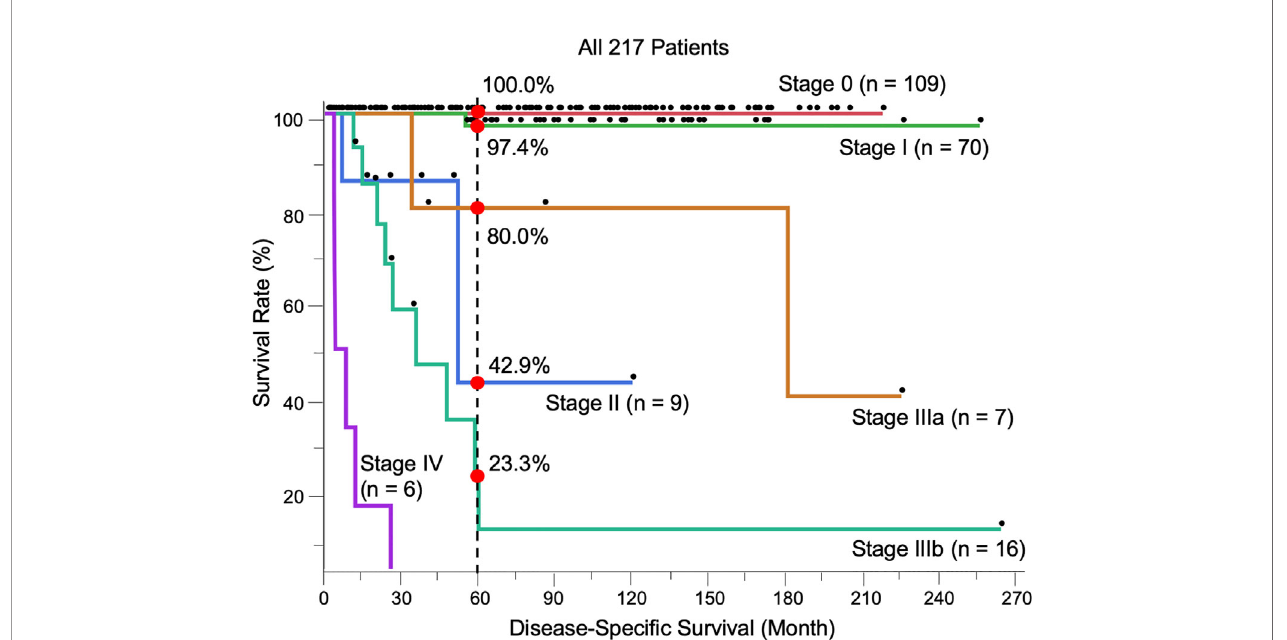
FIGURE 1 | Kaplan-Meier disease-speci fi c survival curves of all 217 patients strati fi ed by TNM stage. The 5-year survival was 100.0% (Stage 0, n = 109), 97.4% (I, n = 70), 42.9% (II, n = 9), 80.0% (IIIa, n = 7), 23.3% (IIIb, n = 16), and 0.0% (IV, n = 6). The log-rank test showed the results of survival as follows; 0 vs I, p = 0.17; I vs II, p < 0.0001; I vs IIIa, p = 0.034; I vs IIIb, p < 0.0001; II vs IIIa, p = 0.47; II vs IIIb, p = 0.24; IIIa vs IIIb, p = 0.066; 0 vs. IV, p < 0.0001; I vs. IV, p < 0.0001; II vs. IV, p = 0.0027; IIIa vs. IV, p = 0.0003; IIIb vs. IV, p <